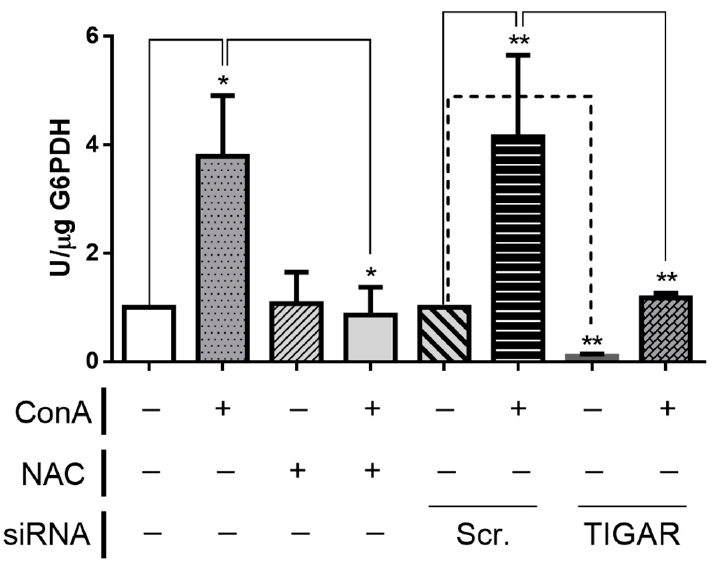
Figure 5. PPP activity in silenced T lymphocytes. Metabolic analysis of enzymatic activity of G6PDH in TIGAR -silenced T lymphocytes; NAC was used at 20 mM, ConA was used at 10 µ g/mL, siRNA TIGAR was used at 75 nM. The activity is presented with U/ µ g and the results are normalized to protein levels. Differences were calculated with two-way ANOVA and Tukey’s multiple comparisons test with a normal-based 95% CI and ± SEM. Significant p values are indicated; * p < 0.05; ** p < 0.01; n = 3.